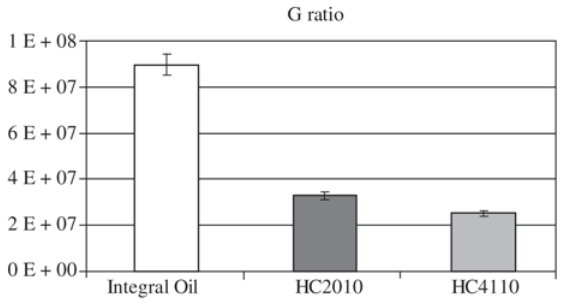
Figure 10. Comparative results for G